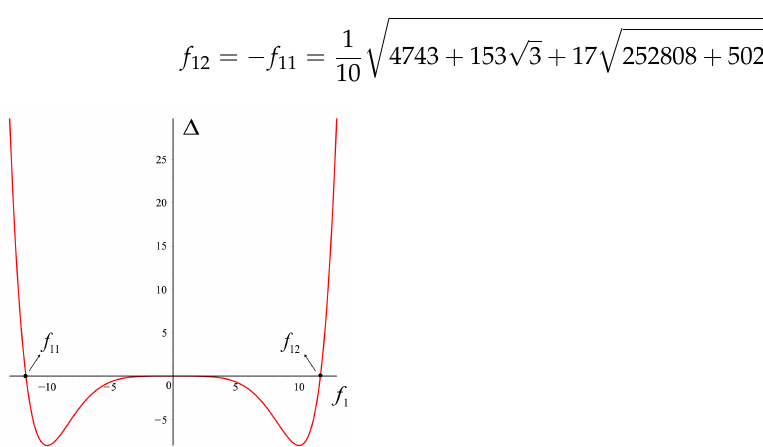
Figure 5. When (cid:52) = 0, there are three solutions: 0, f 11 and f 12 .